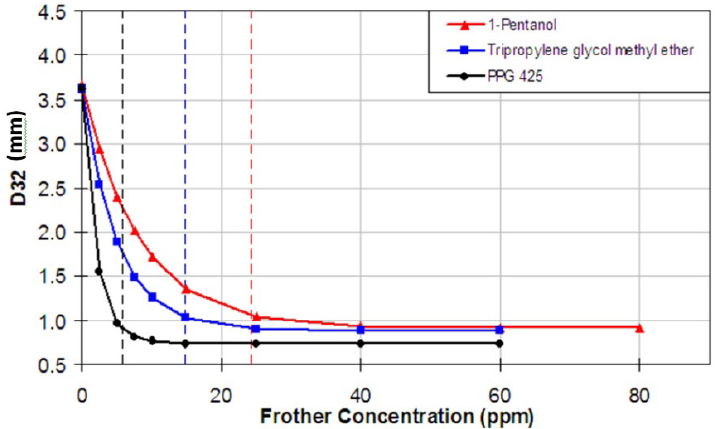
Figure 5. The effect of frother addition on D coalescence concentration (CCC)95 is noted by the vertical dashed line.